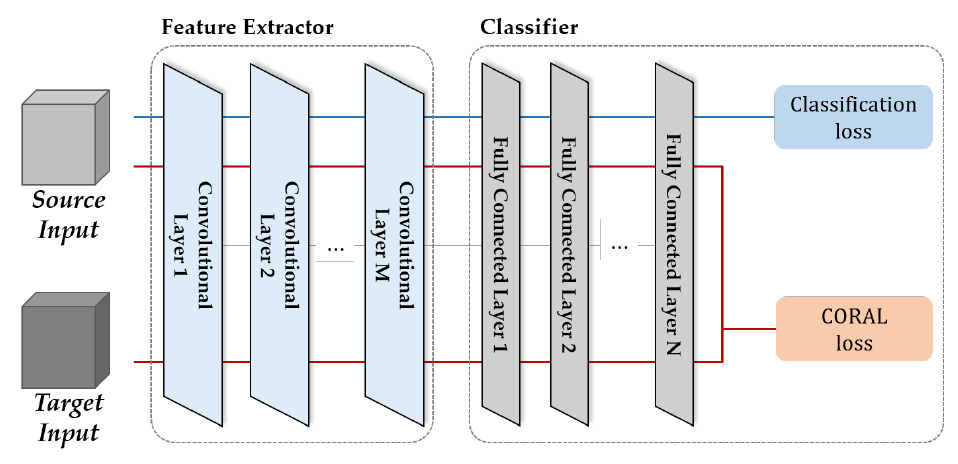
Figure 4. The architecture of the Deep CORAL domain adaptation.